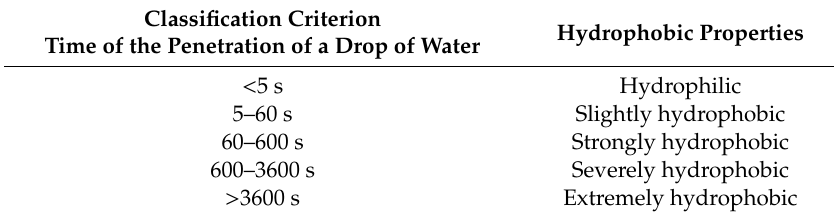
Table 1. Classification criterion of hydrophobic properties